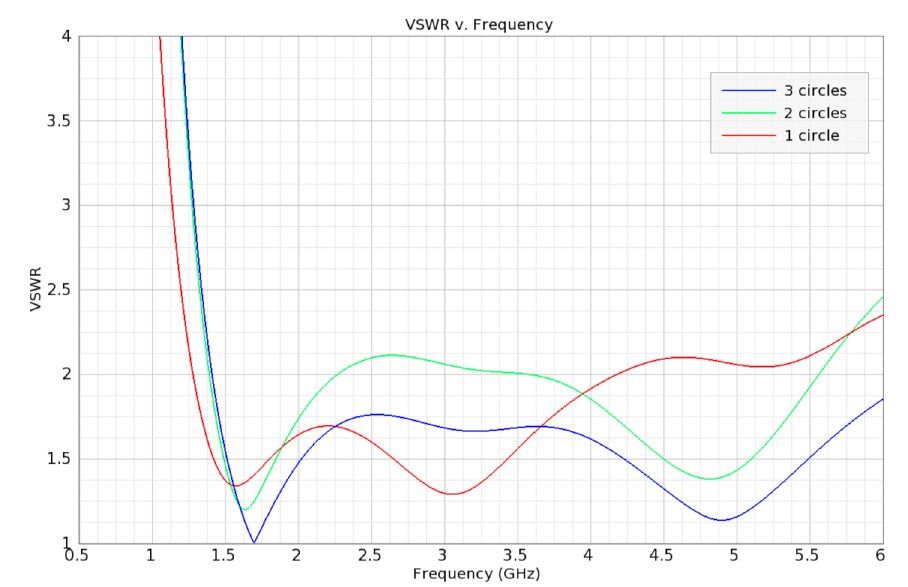
Figure 15. The impedance matching of three optimized antennas for on-body position.